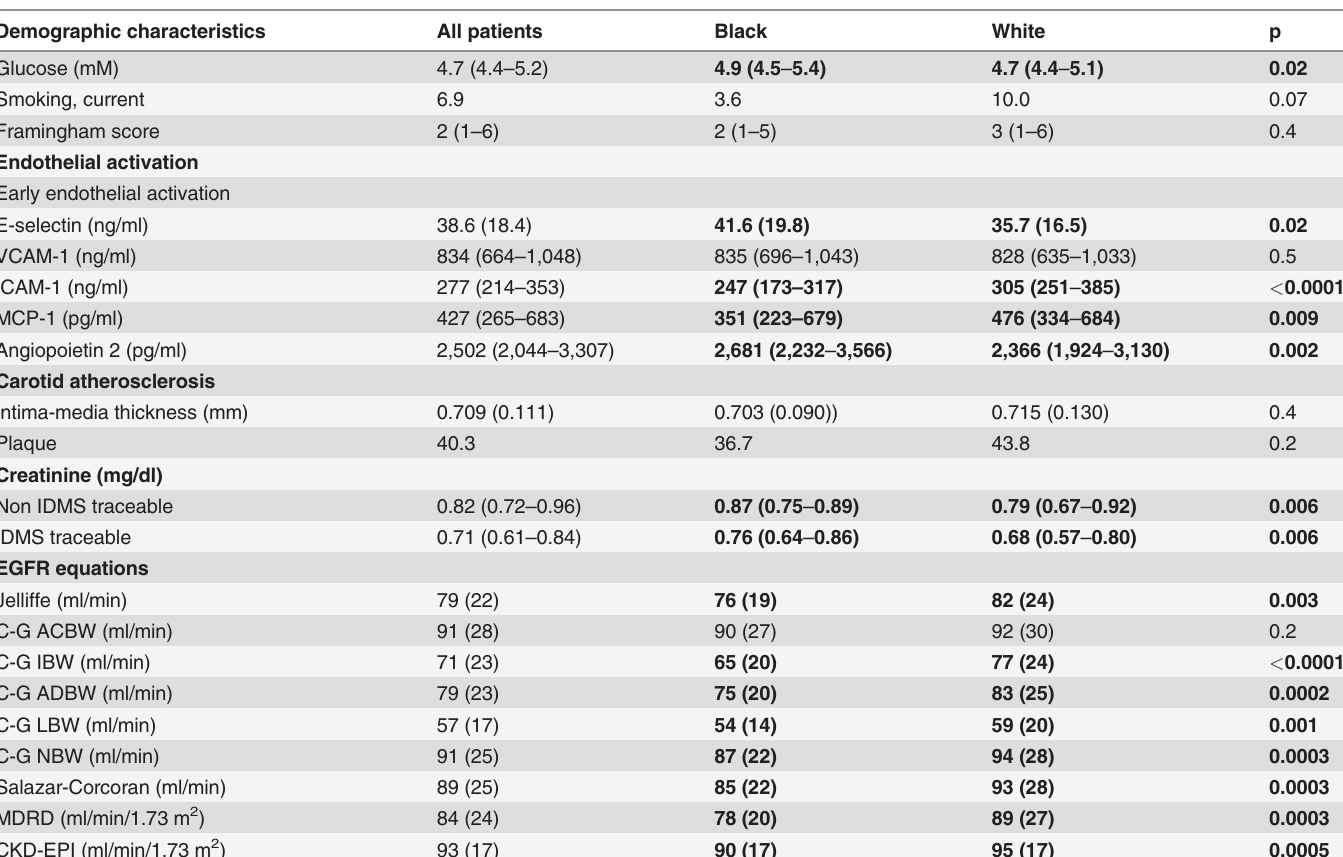
Table. Demographic characteristics, adiposity indices, RA characteristics and traditional CVD risk factors were related to kidney function equations. The Framingham score was significantly associated with 7 of the eGFR equations and was included in subsequent analysis to account for potential confounding by traditional CVD risk